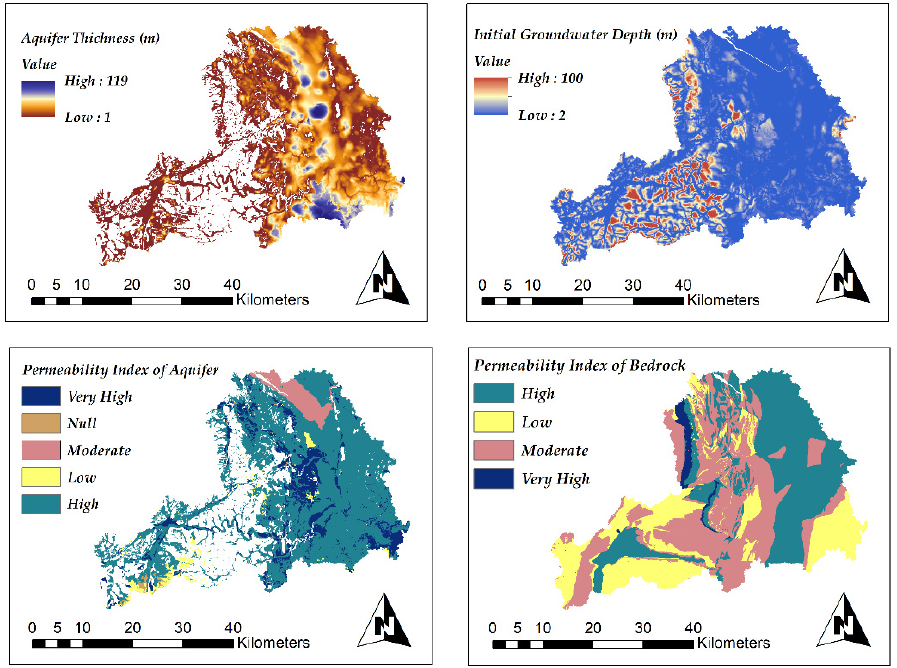
Figure 3. Maps of aquifer thickness (m), initial groundwater depth, and permeability indices for the aquifer and bedrock in the Dee River basin.